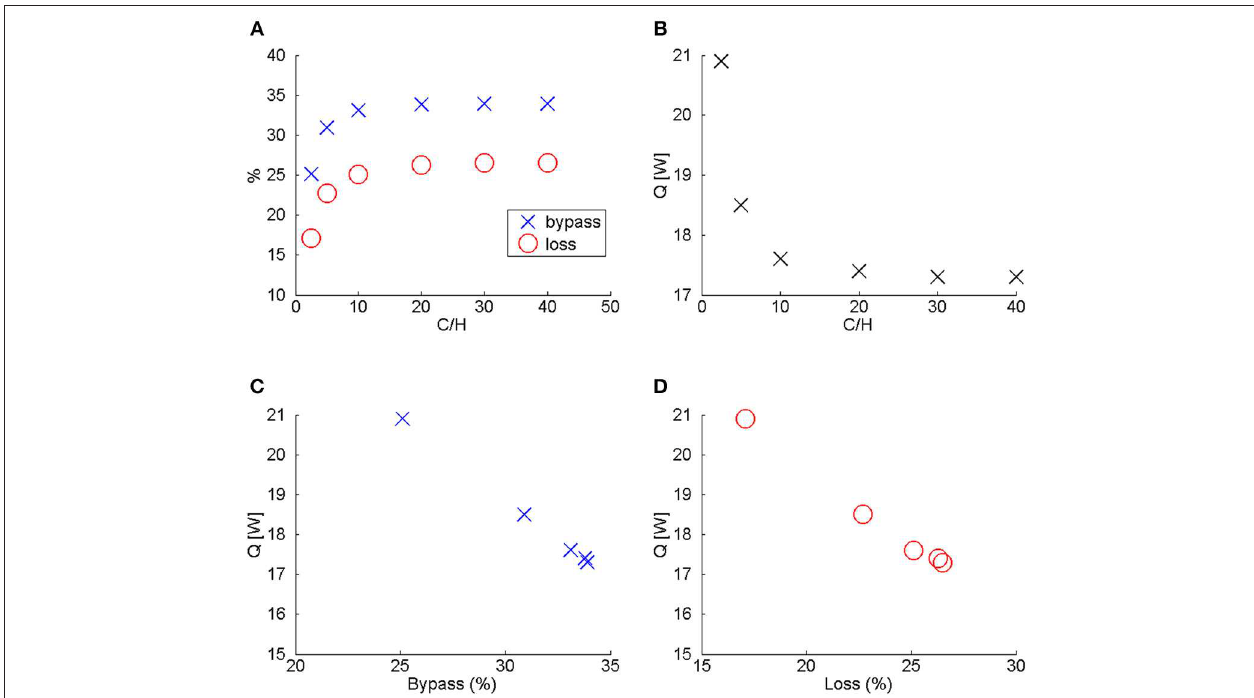
Table 1 summarizes all simulations performed to study the effects of geometry and operating conditions on bypass, loss, pressure drop, and heat